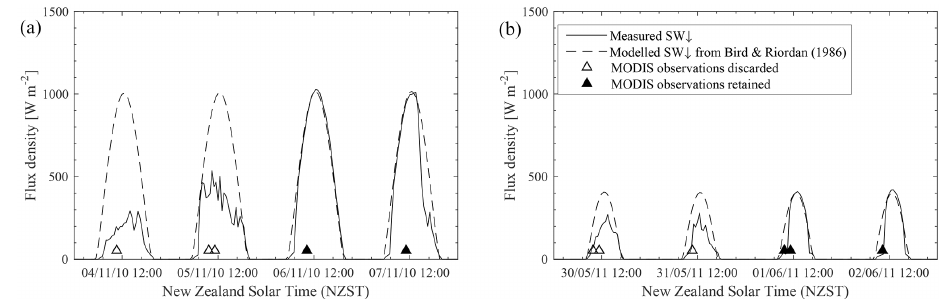
Figure 6. Measured SW ↓ compared to that predicted by integrating the SPCTRAL2 clear-sky solar spectral model of Bird and Riordan (1986) over the range of wavelengths captured by the pyranometer i.e. (300–2800nm) over 4 days in summer (a) and winter (b) . Solid triangles correspond to MODIS observations retained in the strict subset of images with guaranteed clear-sky conditions. Empty triangles would be discarded from this subset even if the MODImLab cloud mask had failed to detect